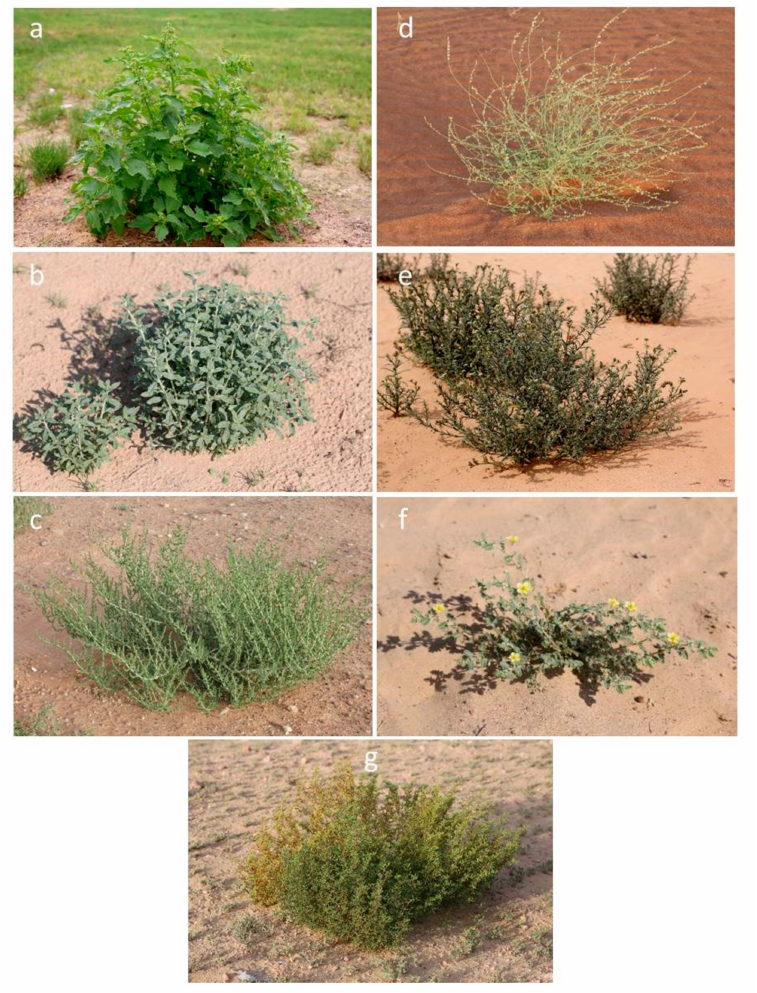
Figure 1. ( a ) Chenopodium murale L. ( b ) Heliotropium digynum Asch. ex C.Chr. ( c ) Salsola imbricata Forssk. ( d ) Dipterygium glaucum Decne. ( e ) Heliotropium kotschyi Gürke. ( f ) Tribulus pentandrus Forssk. ( g ) Zygophyllum qatarense